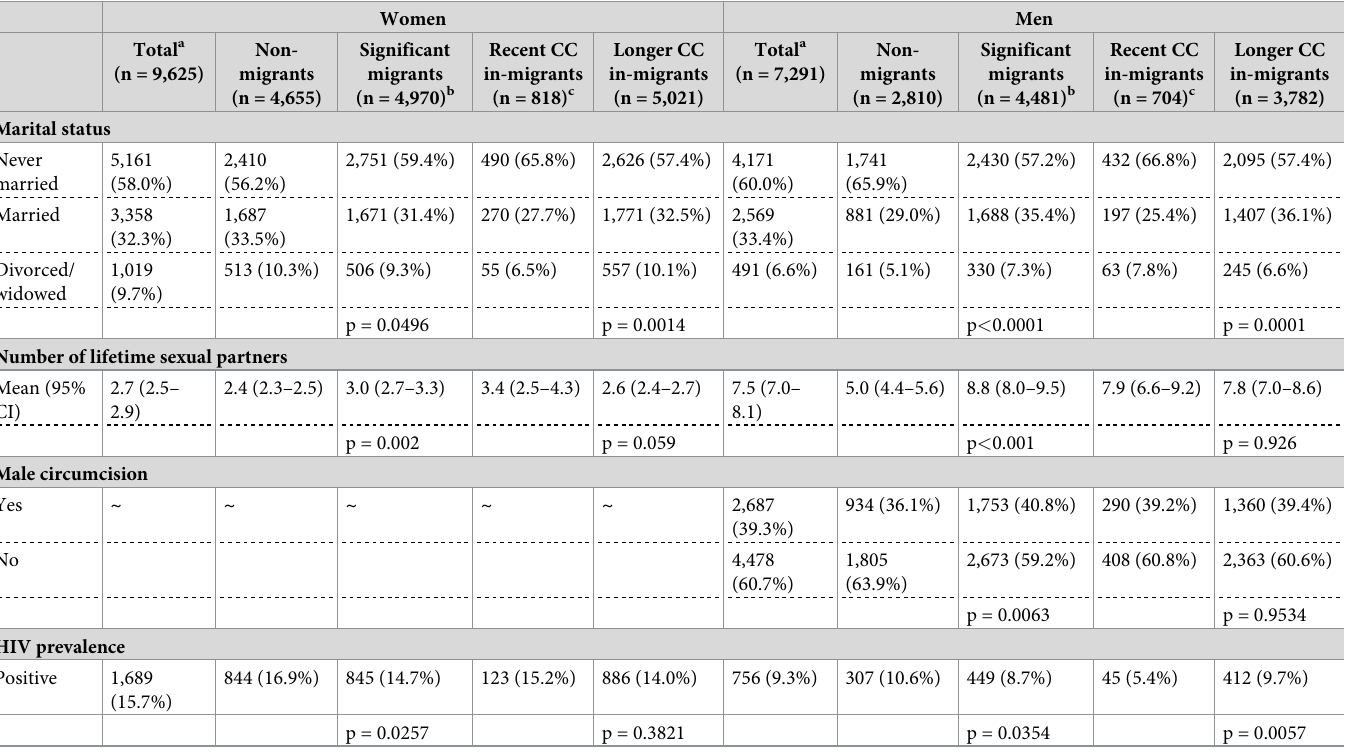
90-90-90 bar chart by migrant type), with the lowest rates among recent (70.9%) compared to long-term cross-community in-migrants (87.7%, p = 0.0003). Compared to non-migrants, there were significantly lower odds of detection of antiretrovirals in significant migrants (OR 0.67, 95% CI 0.51–0.88; Table 3), and significant migrants had almost 40% lower odds of VLS (OR 0.67, 95% CI 0.50–0.88). Recent cross-community in-migrants also had lower awareness (OR 0.45, 95% CI 0.26–0.79) and lower odds of VLS (OR 0.54, 95% CI 0.34–0.86) than long- term cross-community in-migrants. On multivariable analysis, the reduced likelihood of having VLS among migrants persisted after controlling for other sociodemographic influences on VLS. In both models, significant migrants (adjusted OR [aOR] 0.73, 95% CI 0.55–0.97; Table 4) or recent cross-community in- migrants (aOR 0.57, 95% CI 0.35–0.92) had lower odds of VLS, as well as those who